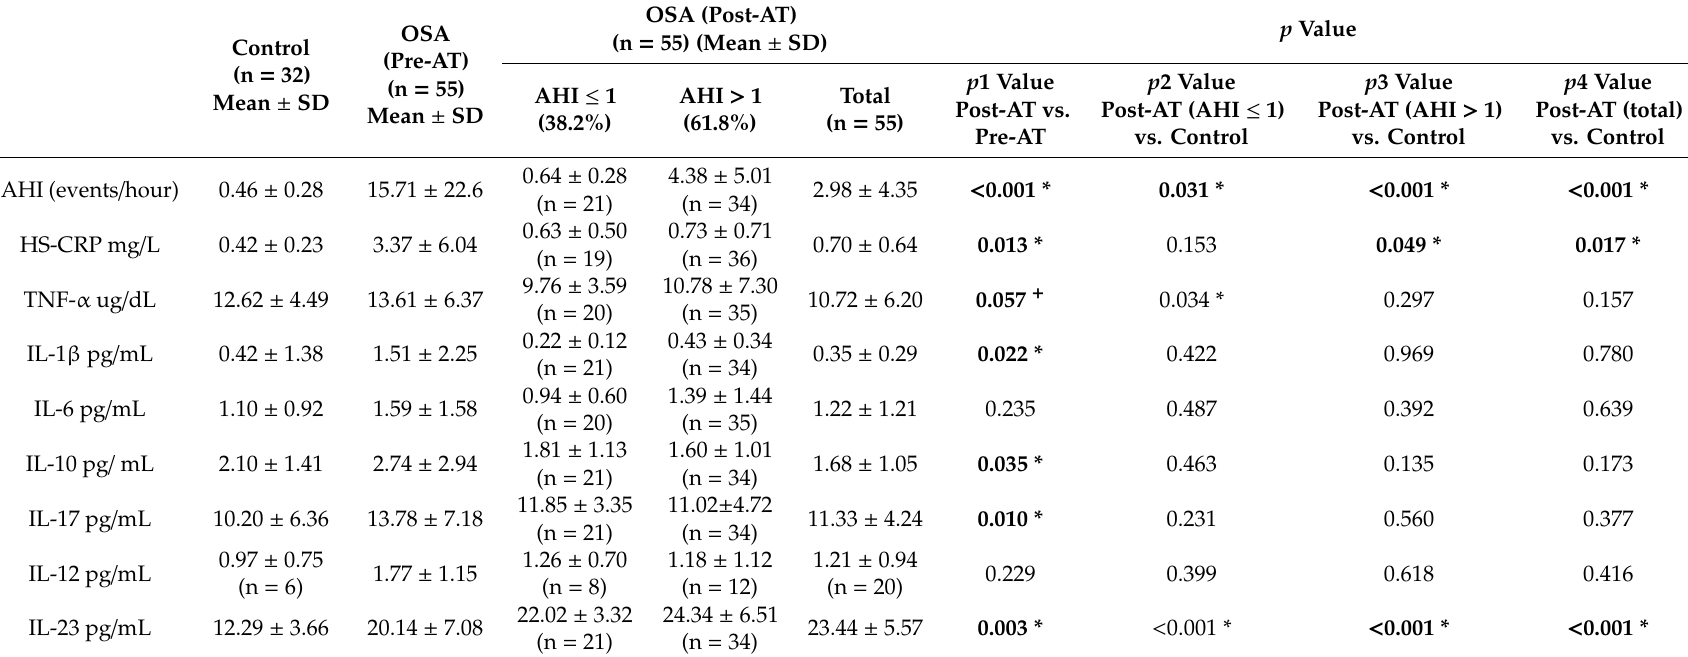
Table 3. Comparison of inflammatory cytokines between groups (AHI > 1 / hour as the cut